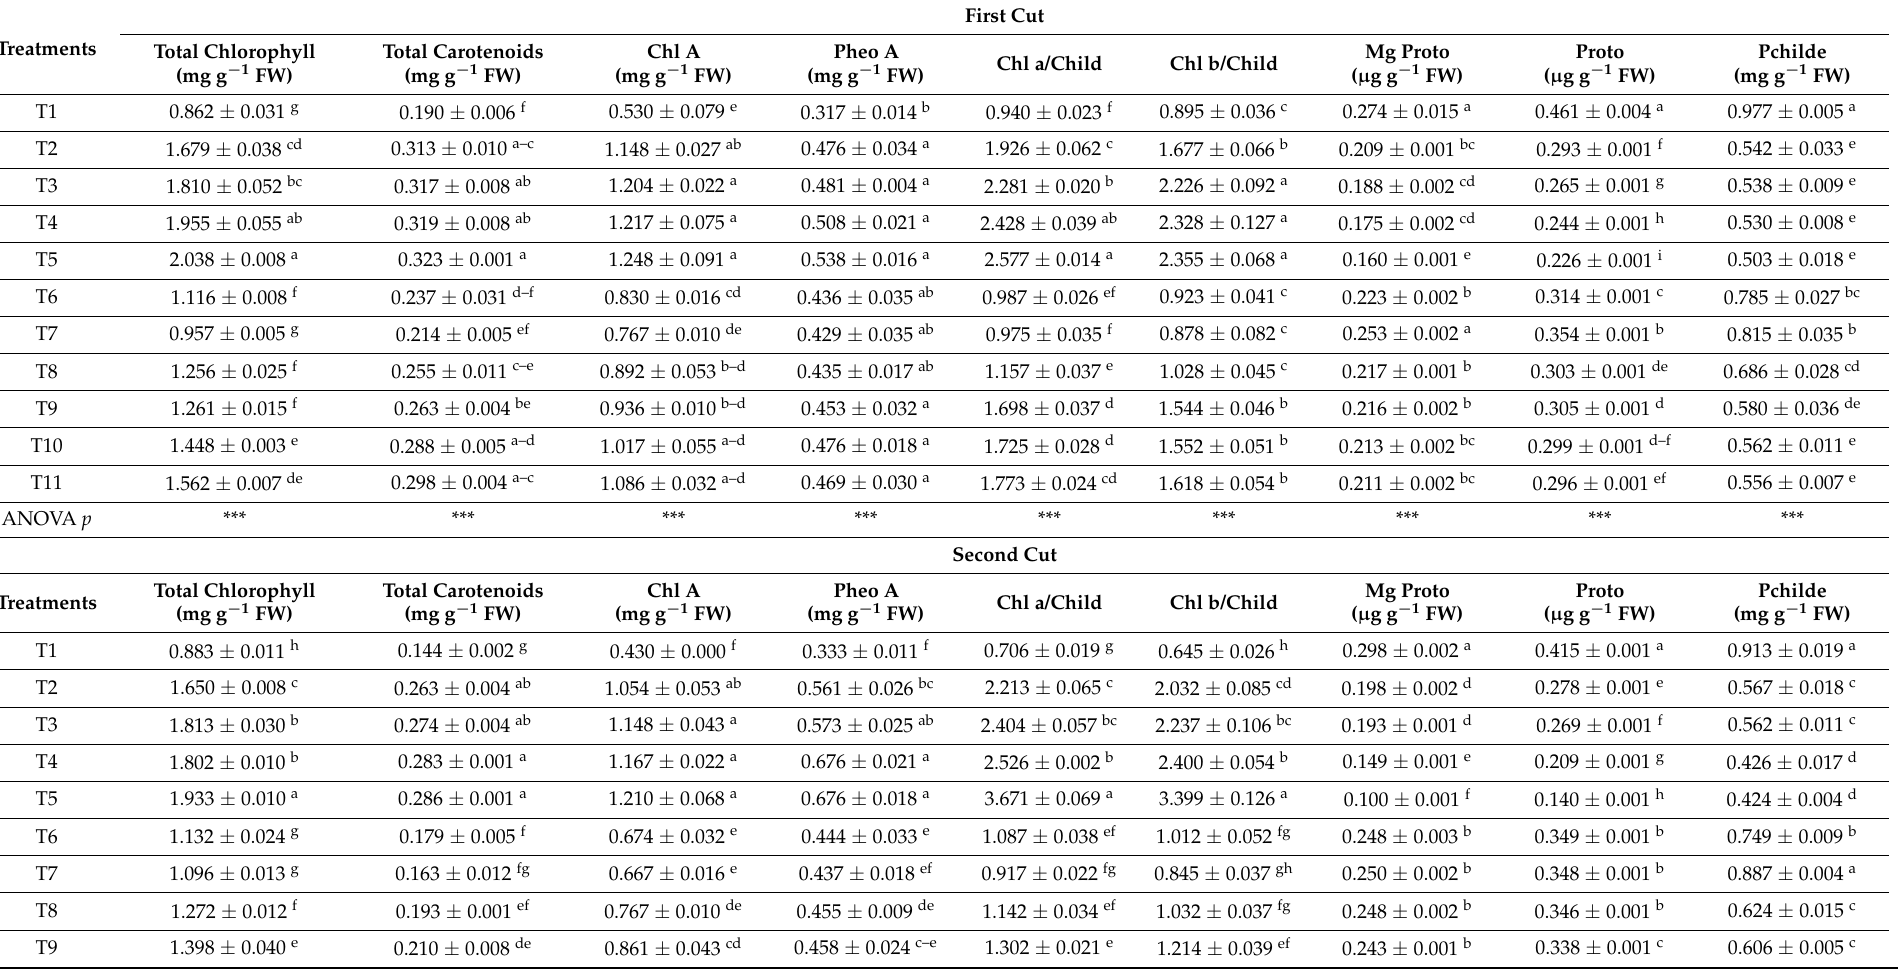
Table 6. Effect of iron (nano, sulfate, and chelated) foliar spray on chlorophyll of Sweet Scented Geranium in the first and second cuts during the 2019 experimental season. Means of three replicates are presented with ±